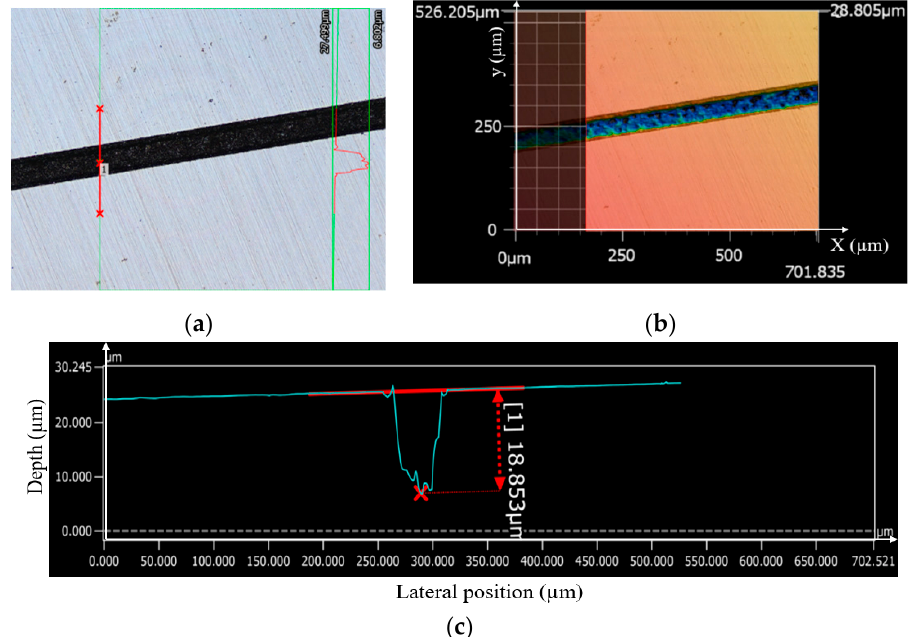
Figure 13. Measurement results of the wafer obtained using a laser confocal microscope (KEYENCE VK-X1000): ( a ) 2D captured image of the wafer, ( b ) 3-D measured profile of wafer, and ( c ) one cross-section of the 3-D profile.